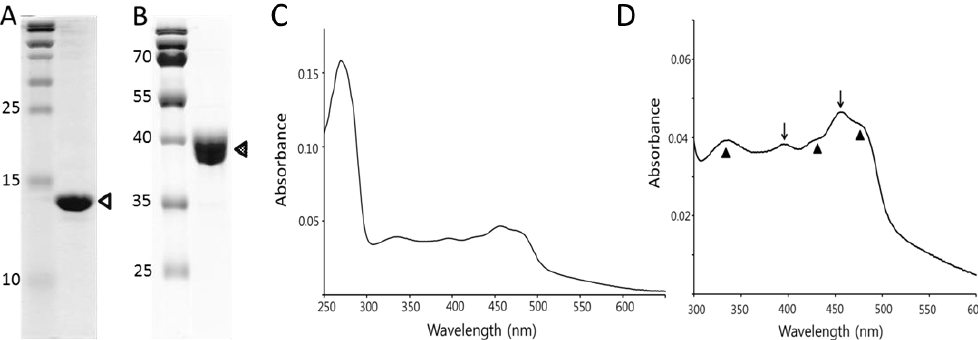
Figure 4. Purification of regulatory (MMOB) and reductase (MMOR) components. ( A ) Purified MMOB (empty triangle) through use of a recombinant plasmid ( pET30a-mmoB ) expression in E. coli (unit: kDa). ( B ) Purified MMOR (dotted triangle) through recombinant plasmid ( pET30a-mmoC ). ( C ) UV–visible spectrum of purified MMOR from M. sporium 5 showing the oxidized MMOR. ( D ) Enlarged UV–visible spectrum of MMOR from 300 to 600 nm. Arrows and triangles represent the oxidized FAD-containing domain and [2Fe–2S] cluster domain, respectively.